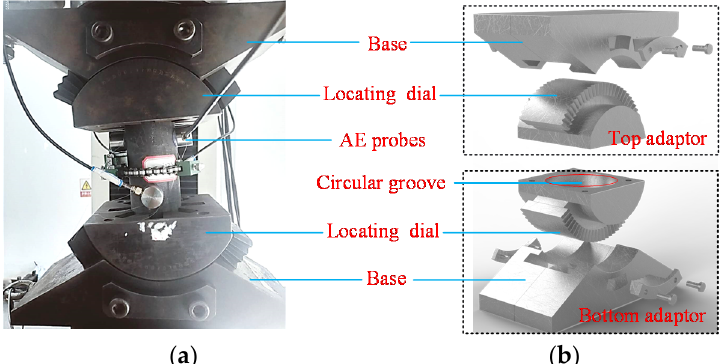
Figure 2. C64.106/1000 kN electrohydraulic servo universal experimental system: ( a ) Loading system; ( b ) Control system.